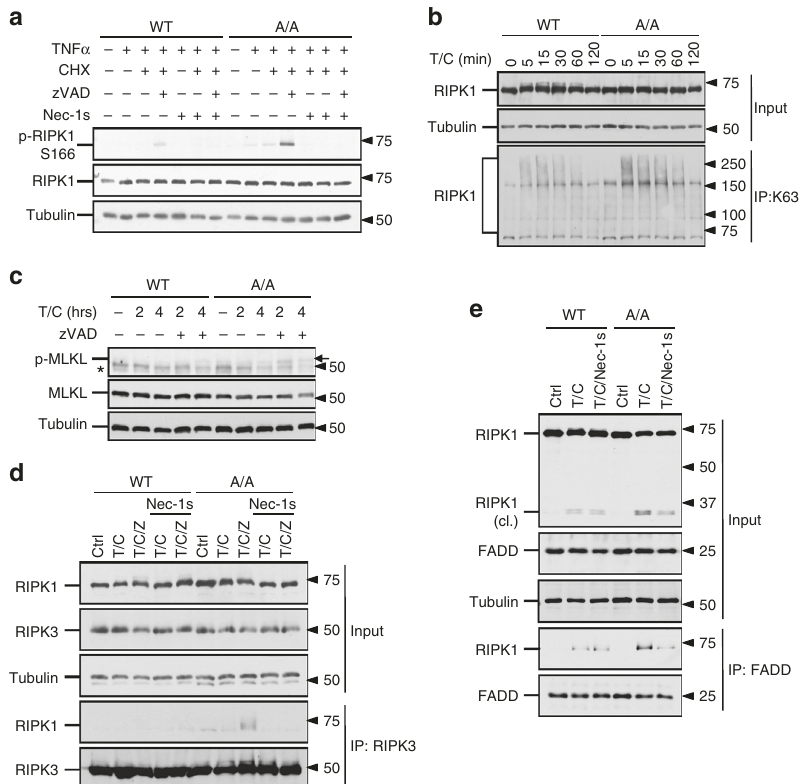
Fig. 6 S321A mutation promotes RIPK1 activation. a RIPK1 S166 phosphorylation in S321A(A/A) mutant. WT and S321A(A/A) MEFs were treated with TNF α (50 ng/ml), CHX (1 µ g/ml), zVAD (20 µ M) and Nec-1s (10 µ M) as indicated for 2 h. b S321A mutation augments RIPK1 K63 ubiquitination in response to TNF α /CHX treatment. MEFs were treated with TNF α (50 ng/ml) and CHX (1 µ g/ml). Lysates under denaturing condition were collected at indicated time-points, immunoprecipitated with K63 antibody and detected with RIPK1 antibody. c Enhanced MLKL phosphorylation in S321A(A/A) cells in response to TNF α /CHX/zVAD. MEFs were treated with TNF α (10 ng/ml), CHX (1 µ g/ml), zVAD (20 µ M) for 2 and 4 h. Arrow, phosphorylated MLKL. d Earlier induction of RIPK1-RIPK3 interaction in S321A(A/A) MEFs induced by TNF α /CHX/zVAD. WT and RIPK1 S321A(A/A) MEFs were treated as a and co-immunoprecipitation was performed with RIPK3 antibody. e Stronger interaction between FADD and RIPK1 in RIPK1 S321A(A/A) MEFs induced by TNF α /CHX was suppressed by Nec-1s. The cells were treated with TNF α (50 ng/ml) and CHX (1 µ g/ml) with or without Nec-1s (20 µ M) for 4 h. Co- immunoprecipitation was performed with FADD antibody. *, nonspeci fi c